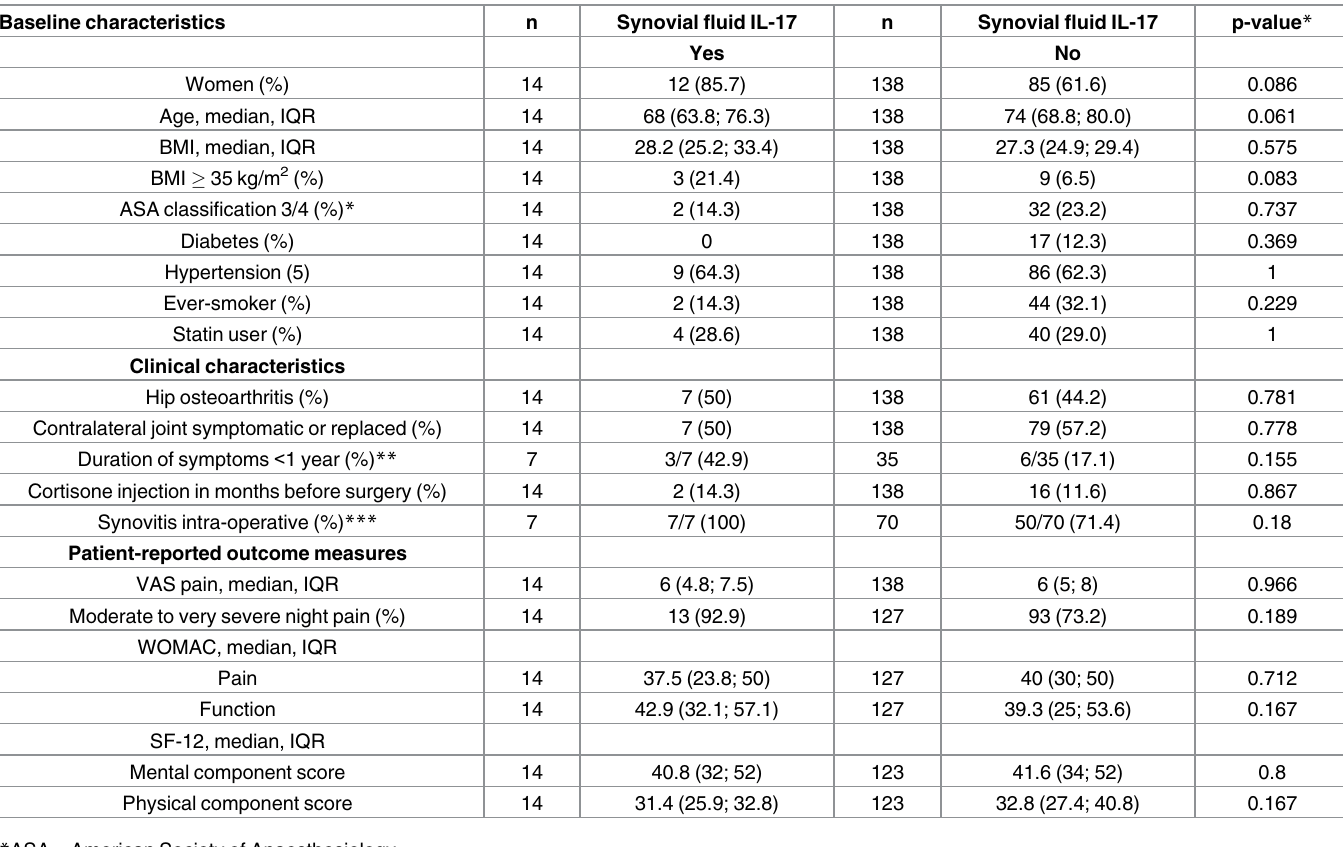
Table 2. Synovial fluid IL-17 levels in relation to baseline and clinical characteristics and patient-reported outcome